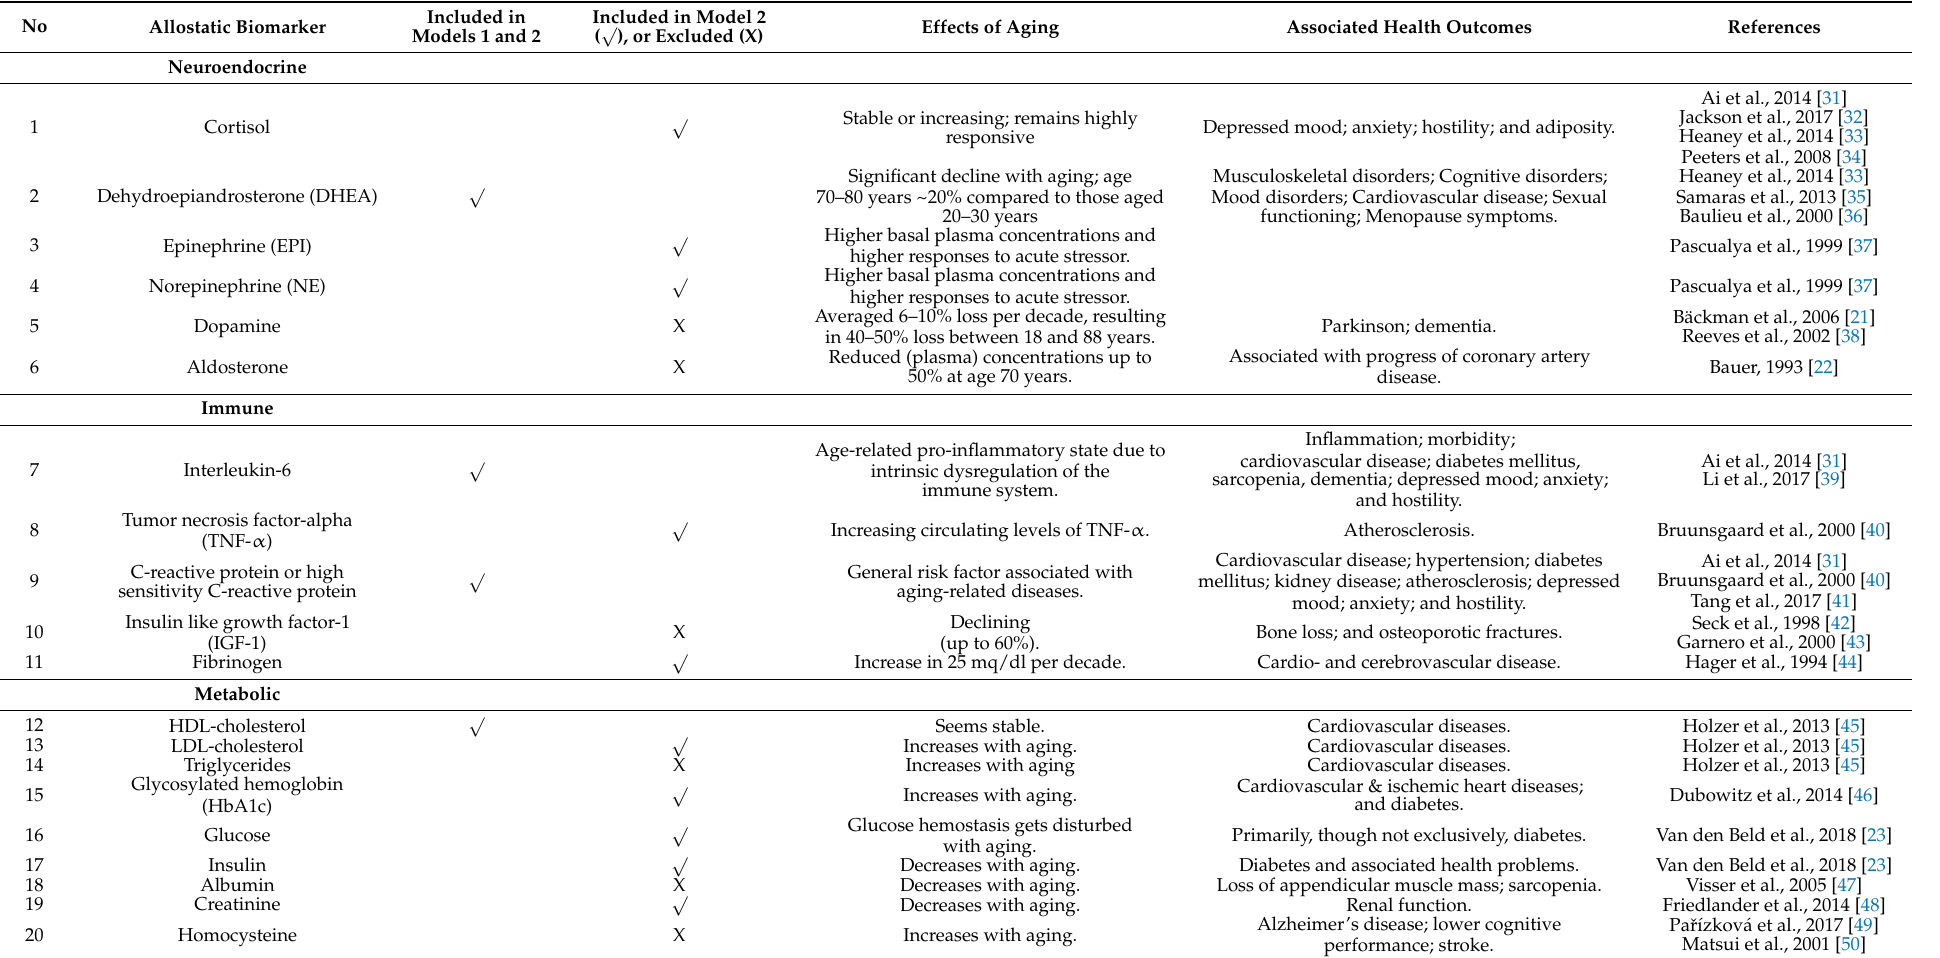
Table 1. Allostatic parameters identified by Juster [1], with in- and exclusion criteria for adoption in either the probability model 1 (see Figures 2 and 3), or the more theoretical framework (see Figure 5), both aiming to capture health status in specifically elderly (aged >60